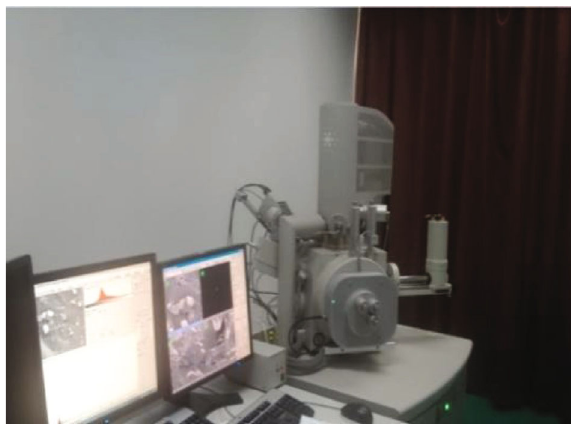
Figure 4: FEI Tecnai G2 20 scanning electron microscope.